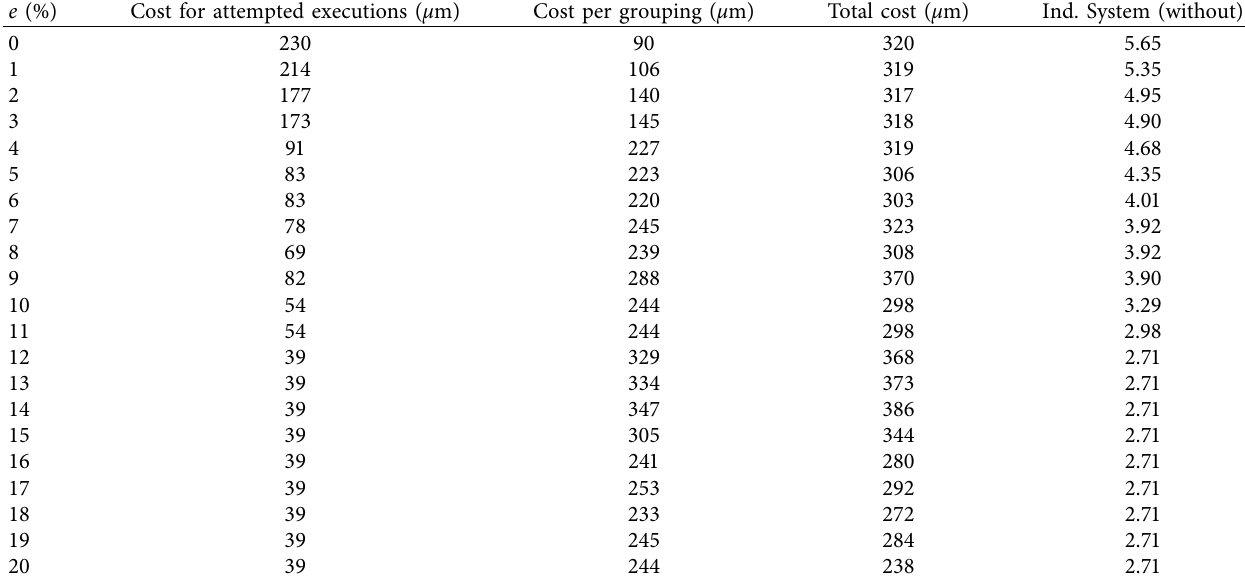
Table 6: Number of executions of each of the activities for the diferent tolerance